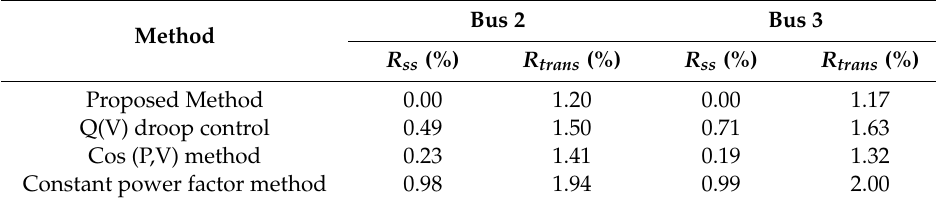
Table 10. Comparison of voltage variations when WT1 and WT2 are disconnected.